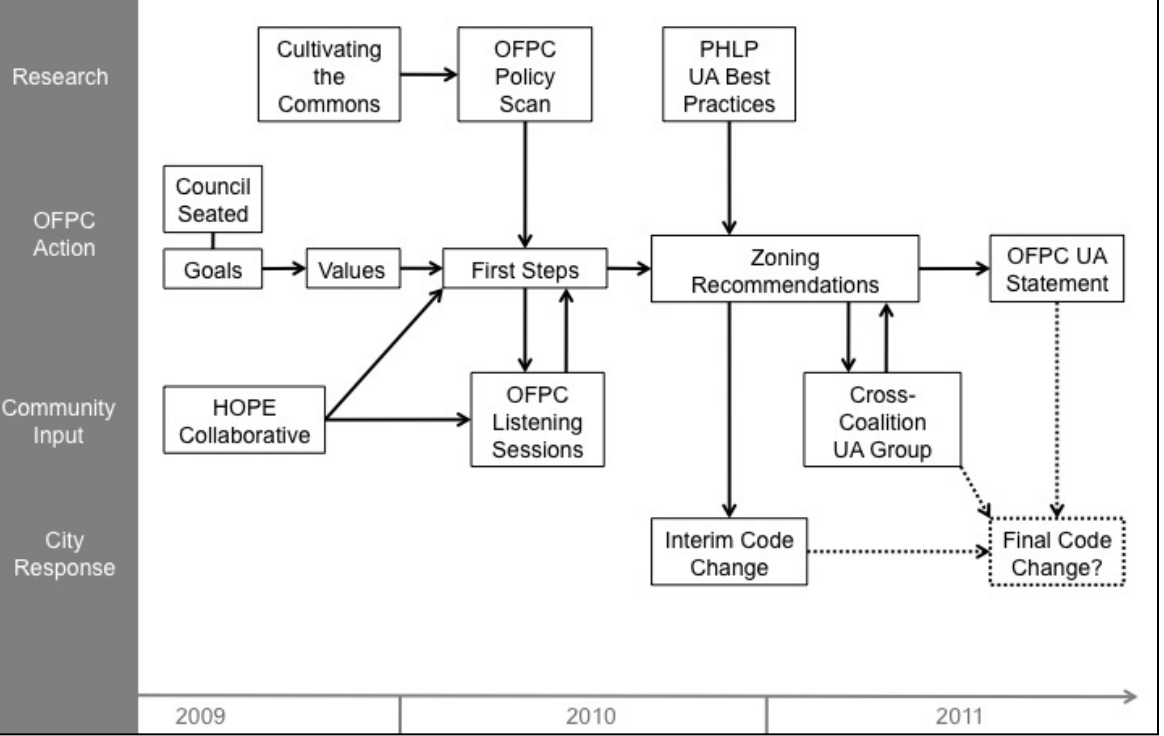
Figure 2. Interactions Between Research, Community Partners, Oakland Food Policy Council, and City Government in the Development of a UA Zoning Recommendations for